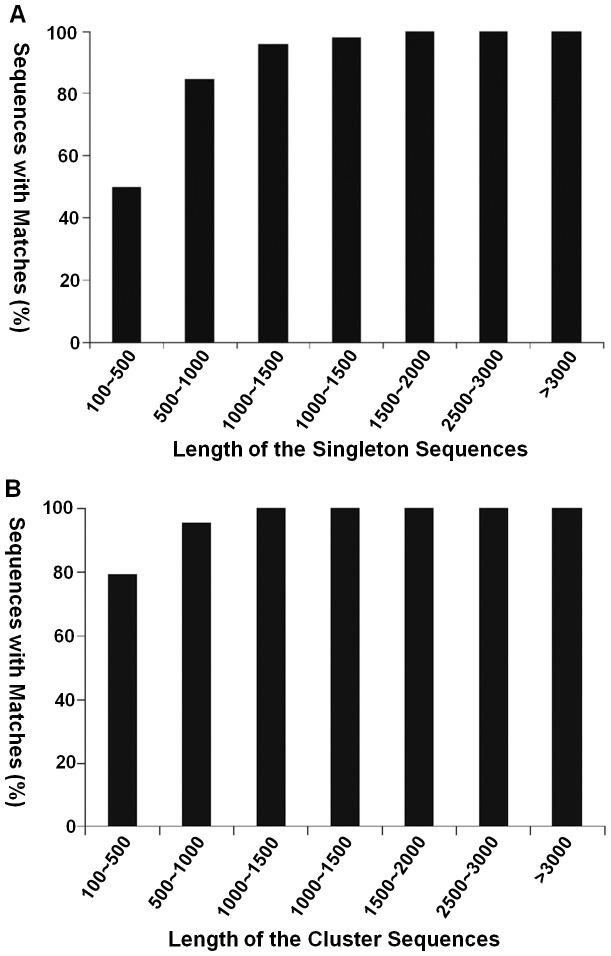
Effect of query length on the percentage of significant matches.(A) Singleton sequences. (B) Cluster sequences. The proportion of sequences with matches (with a cut-off E-value of 1.0E−5) in NR databases is greater among the longer assembled sequences.